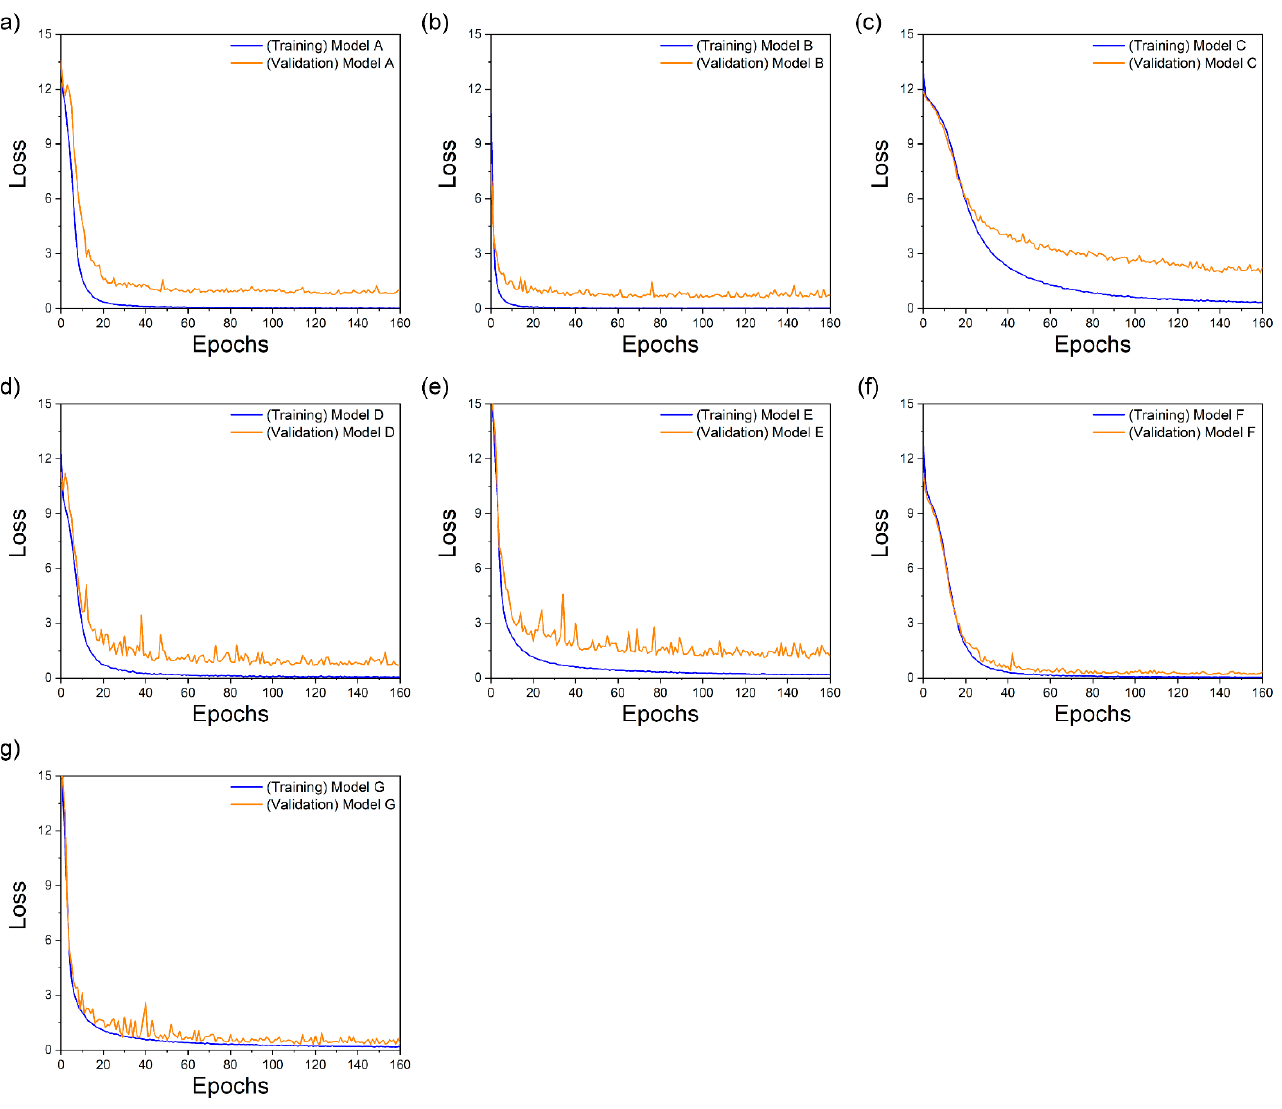
Figure 8. Training and validation loss of the collected dataset. Models ( a ) A; ( b ) B; ( c ) C; ( d ) D; ( e ) E; ( f ) F; and ( g ) G.